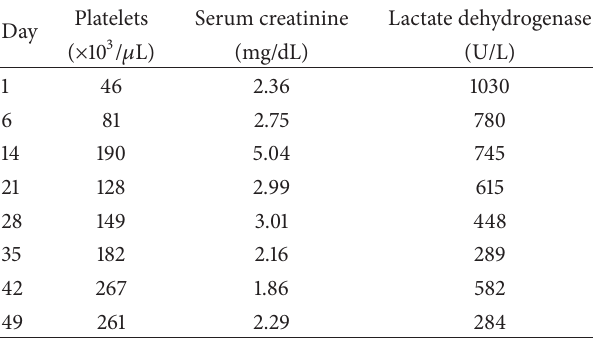
Table 1: Platelets, serum creatinine, and lactate dehydrogenase measurements from day 1 of initial hospitalization until discharge. Plasma exchange was initiated on day 1 and stopped on day 2. Ecu- lizumab was initiated on day 12. Renal replacement therapy was initiated on day 16 and stopped on day